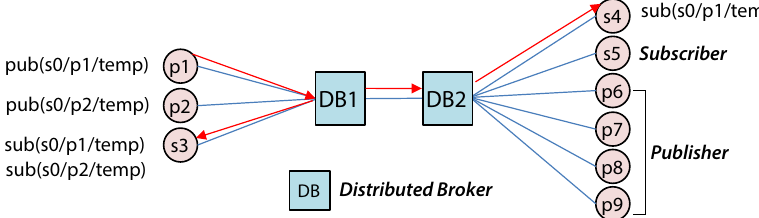
Figure 3. MQTT message delivery process between distributed brokers.